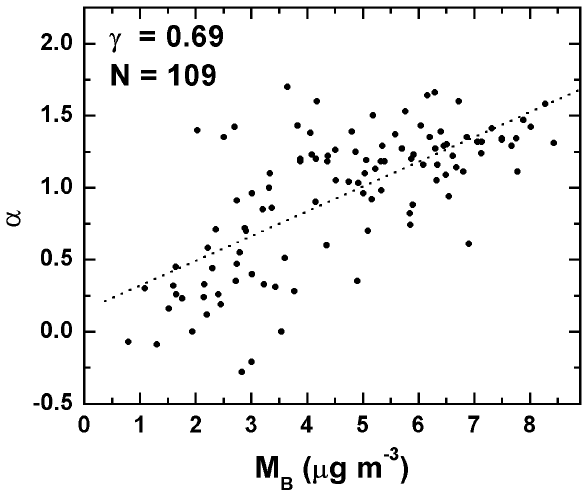
Fig. 11. Scatter plot showing the variation of Angstrom exponent Figure 11. Scatter plot showing the variation of Angstrom exponent ( α ) with black carbon mass ( α) with black carbon mass concentration ( M B ) . Here N is the number of days on which simultaneous observation of spectral AOD concentration (M B ). Here N is the number of days on which simultaneous observation of spectral and M B is available and γ is the correlation AOD and M B is available and γ is the correlation coefficient.